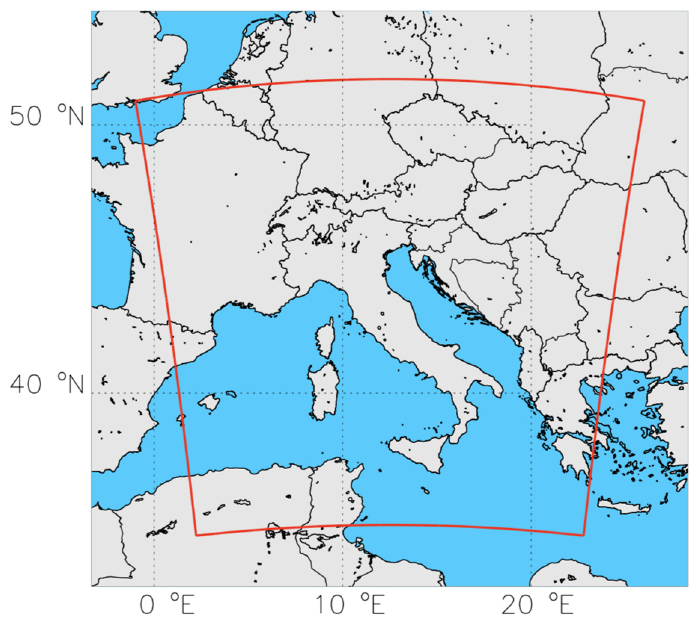
Figure 6. RAMS@ISAC model domain. Table 2. RAMS@ISAC grid parameters. NNXP and NNYP are model grid points in both WE and SN directions, while NNZP indicates the number of vertical levels. DX and DY are the grid spatial dimensions in the WE and SN directions, respectively. Lx, Ly and Lz represent the domain extension in WE and SN directions and in the vertical direction, respectively. CENTLON and CENTLAT in- dicate the coordinates of the grid center. NNXP